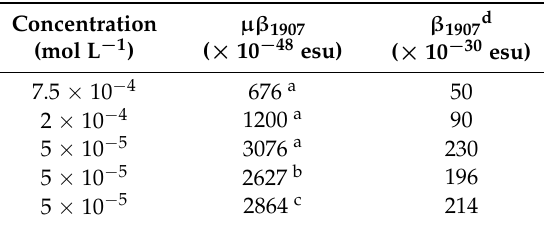
Table 4. EFISH µβ 1907 values as a function of the concentration and of the solvent for chromophore 1. Adapted from J. Phys. Chem. C 2009 , 113 ,